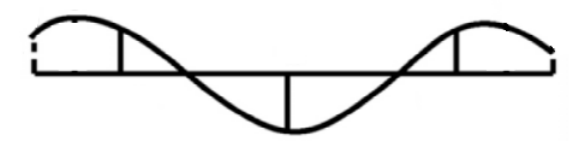
Fig. 5. The third-order vibration shape diagram of the